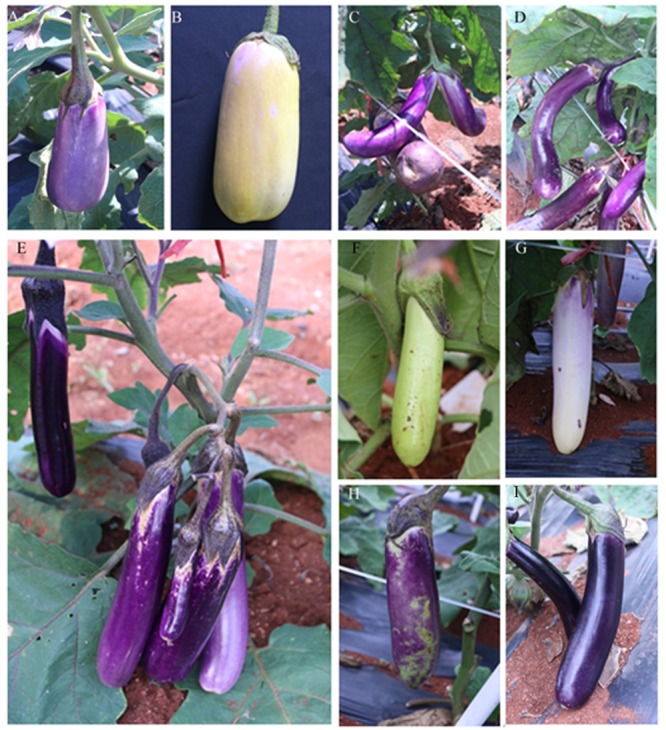
Representative mutants relate to fruit color and morphology. (A) V40-1 developed a small and short fruit, (B) 48-5 developed large eggplant fruit, (C) 55-3 developed malformed fruit, (D) A3-6 developed curve eggplant fruit, (E) P47-3 bore many fruits, (F) L6-4 developed green eggplant fruit peel, (G) U36-1 developed a white eggplant fruit peel, (H) L6-2 developed variegated fruit peel color, (I) 55-6 developed purple-black fruit peel.